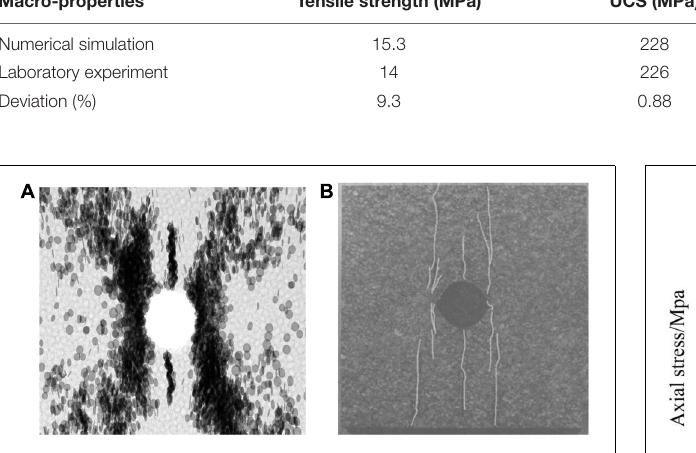
FIGURE 3 | Failure modes of a specimen with a circular hole obtained through simulation and experiment. (A) Numerical result. (B) Experimental result. Adapted from Carter BJ, Lajtai EZ, Petukhov A. Primary and remote fracture around underground cavities. International Journal for Numerical &